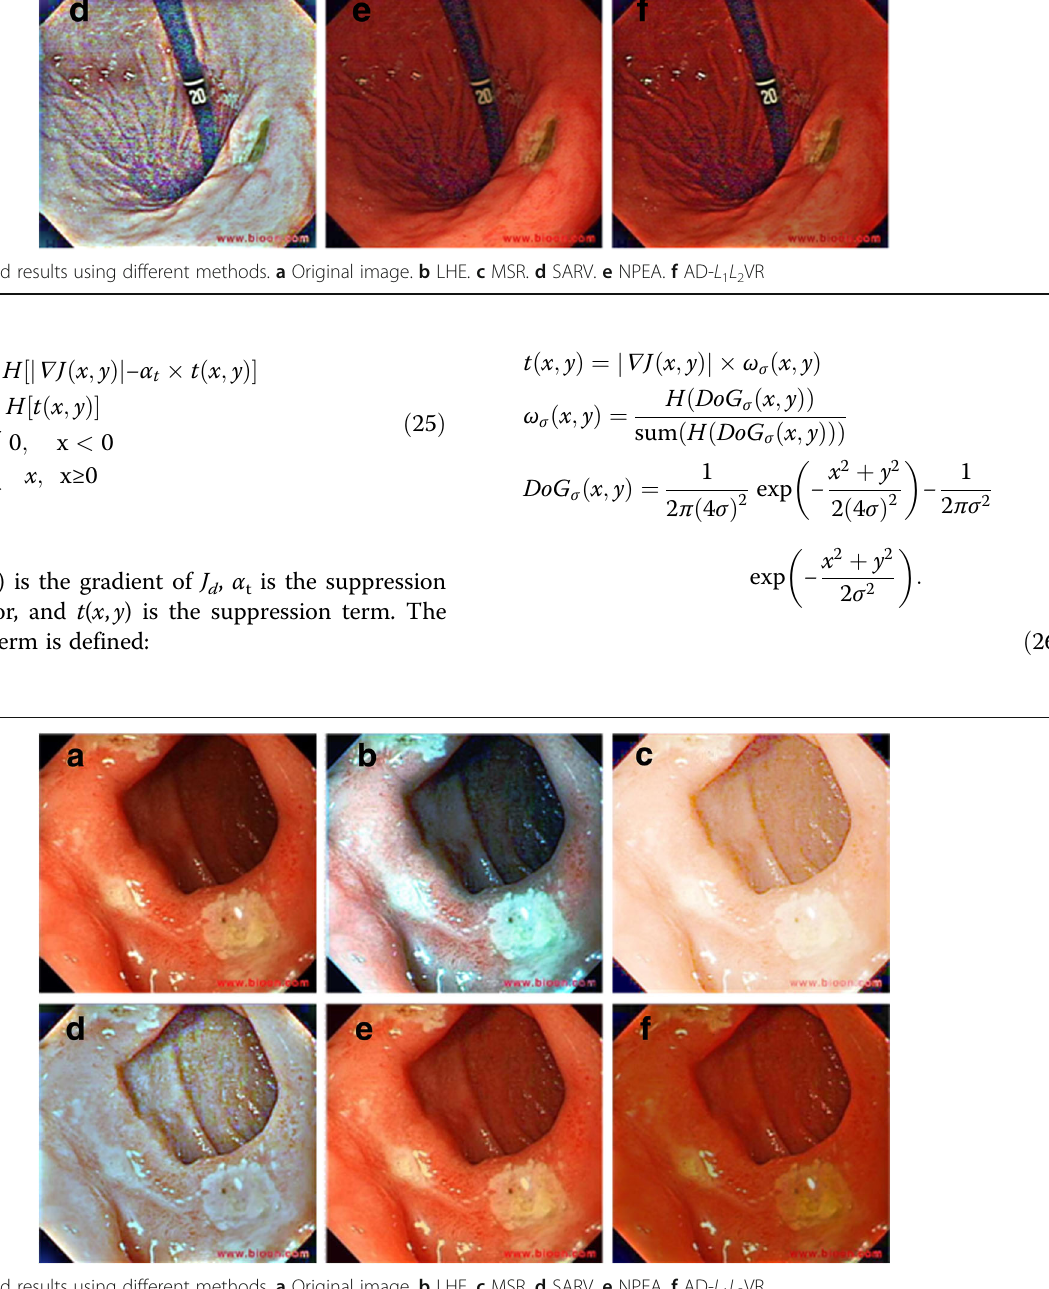
Fig. 8 Enhanced results using different methods. a Original image. b LHE. c MSR. d SARV. e NPEA. f AD- L 1 L 2 VR